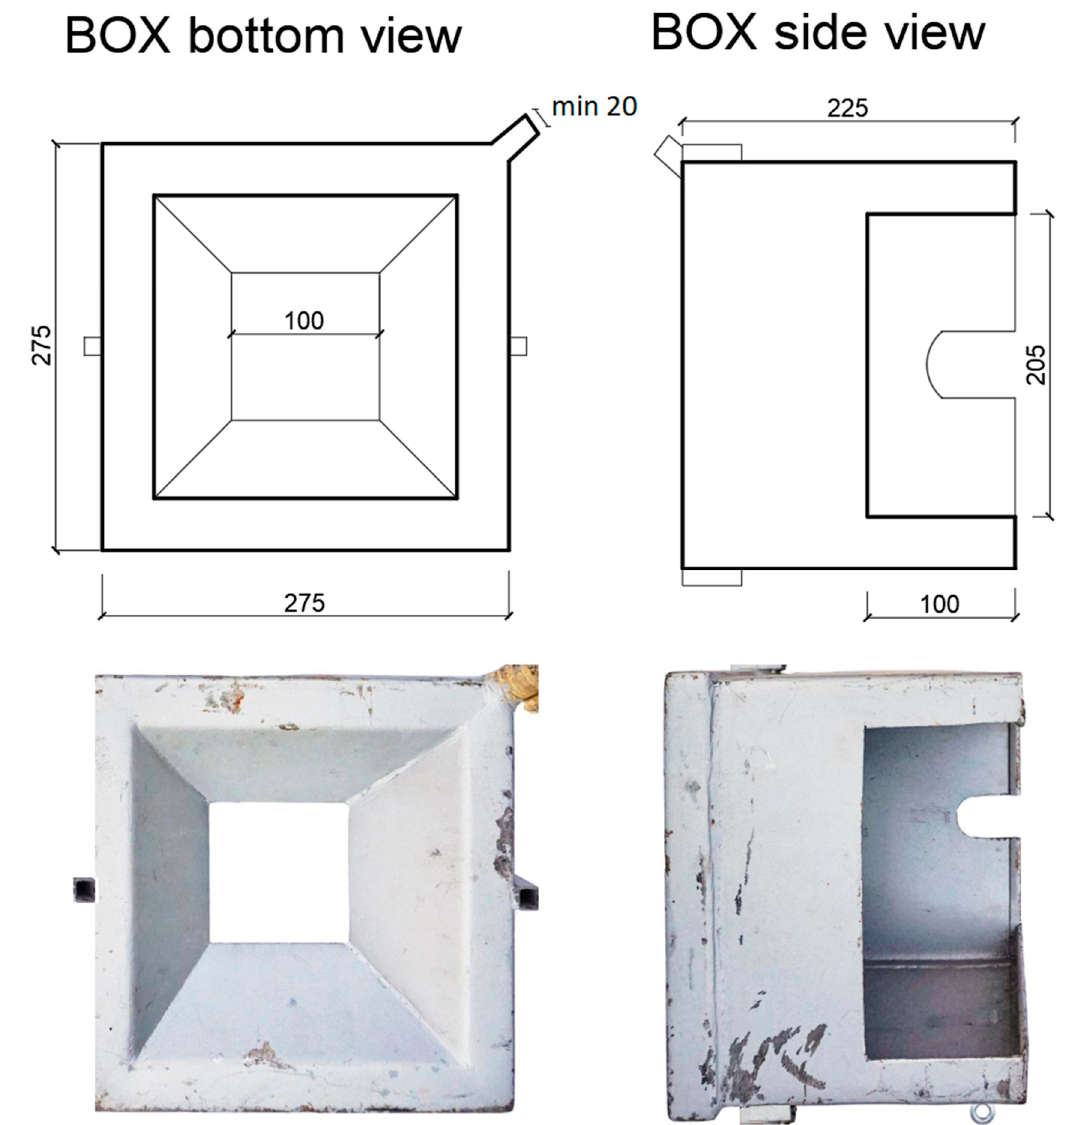
Figure 2. Box for catching excess water.